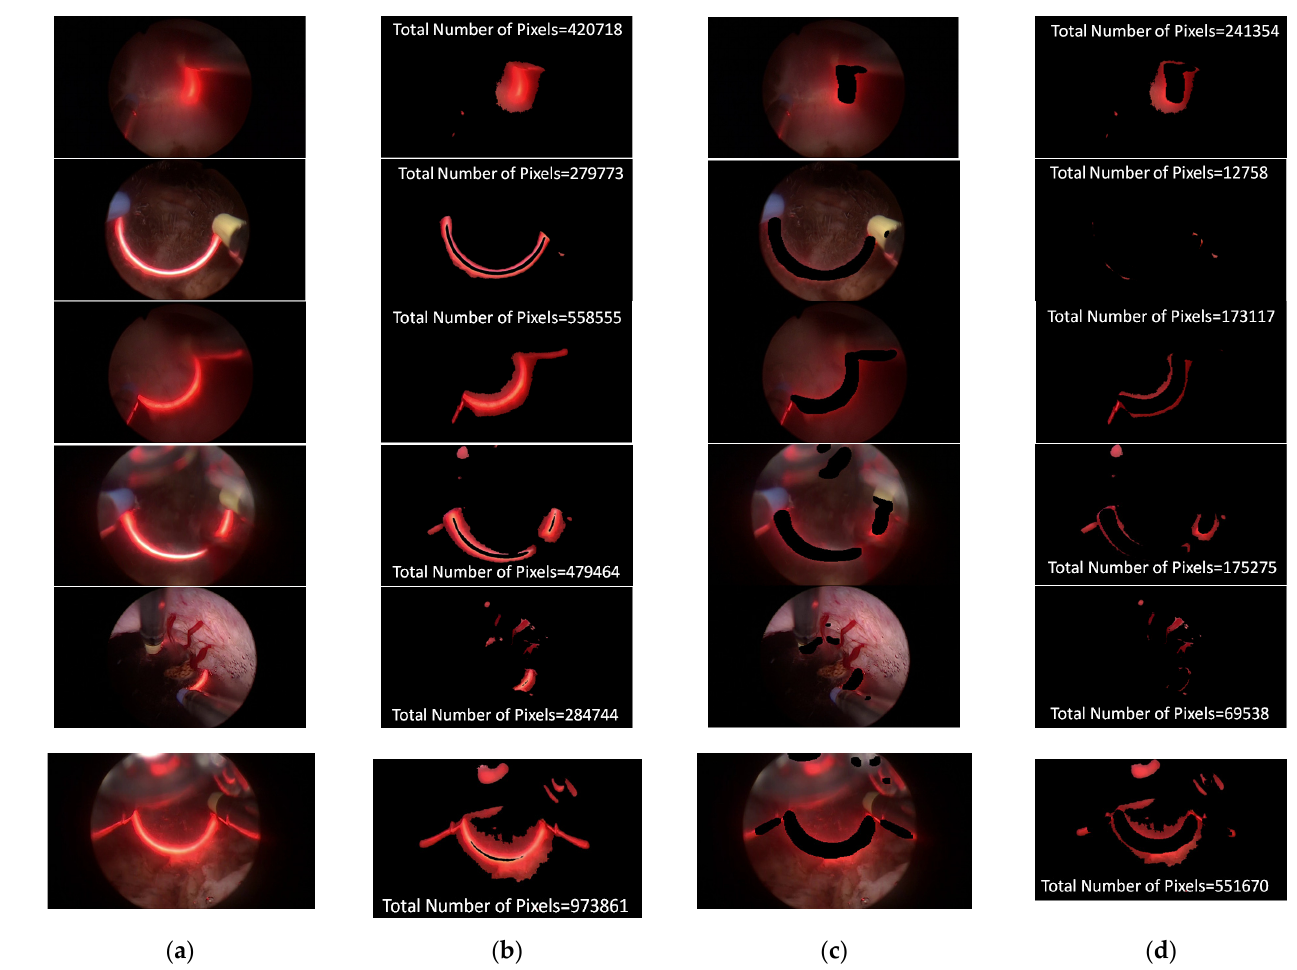
Figure 3. The IoU and Dice Coefficient for ResUnet model.